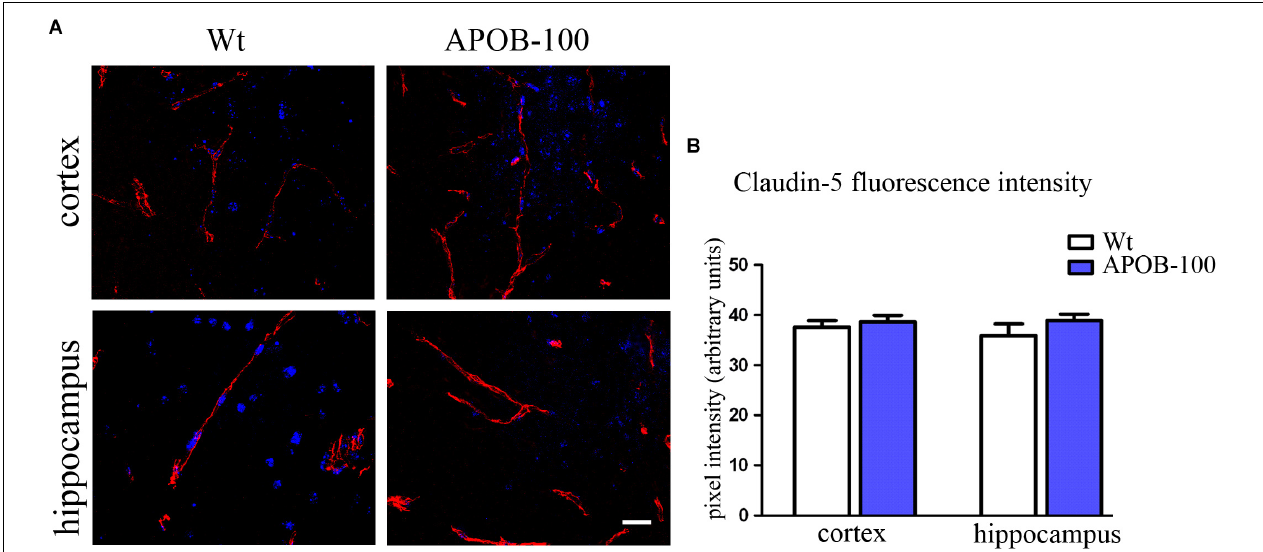
FIGURE 2 | Claudin-5 immunostaining pattern (red) in the cortex and hippocampus of wild-type (Wt) and APOB-100 transgenic mice (APOB-100), counterstained with DAPI (blue) (A) . Scale bar: 20 µ m. Quantification of fluorescence intensity of claudin-5 immunolabeling in the frontal cortex and hippocampus of Wt and APOB-100 transgenic mice (B)